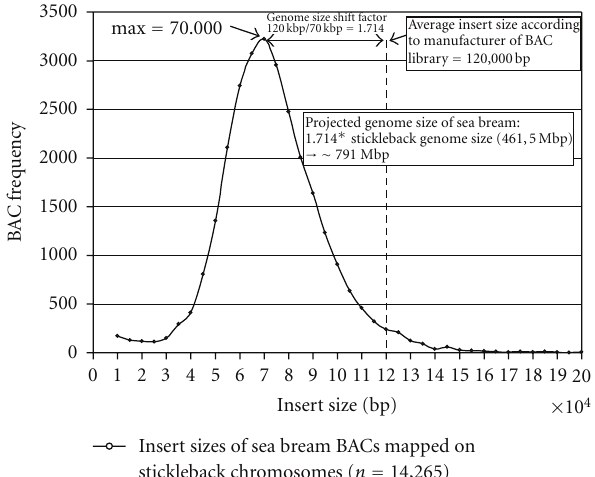
Figure 1: Insert size frequency distribution of consistently mapped sea bream BACs to chromosomes of three-spined stickleback ( Gasterosteus aculeatus ). Mapped BACs exhibit a shift to lower insert sizes compared to insert sizes of the BACs observed by pulse field gel-electrophoresis (according to manufacturer of the BAC library Amplicon Express, data not shown). This shift reflects the genome size di ff erence between sea bream and stickleback.